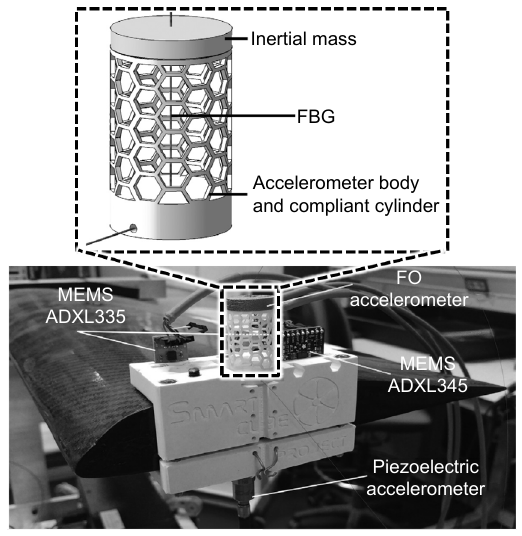
Fig. 17 | A light-weight FBG based accelerometer . Figure repro- duced with permission from ref. 83 , Elsevier.